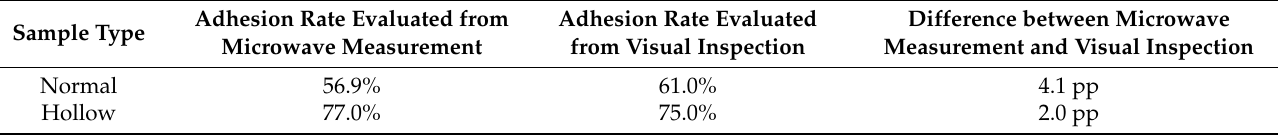
Table 1. Comparison of the adhesion rate between the fabricated system and visual